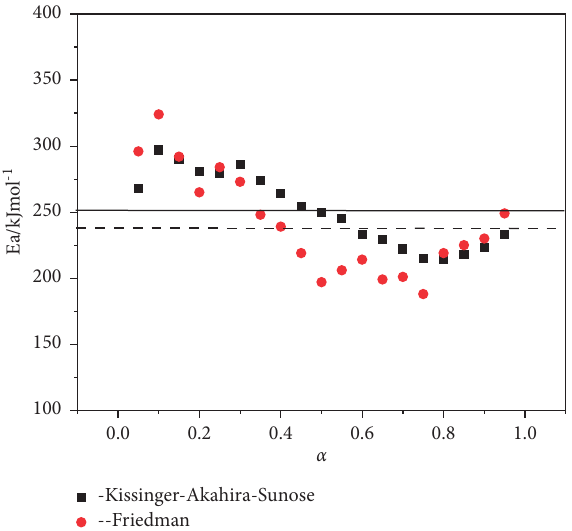
Figure 4: Dependence of the activation energy ( E a ) on the conversion degree ( α ) for the p-EGF:AA